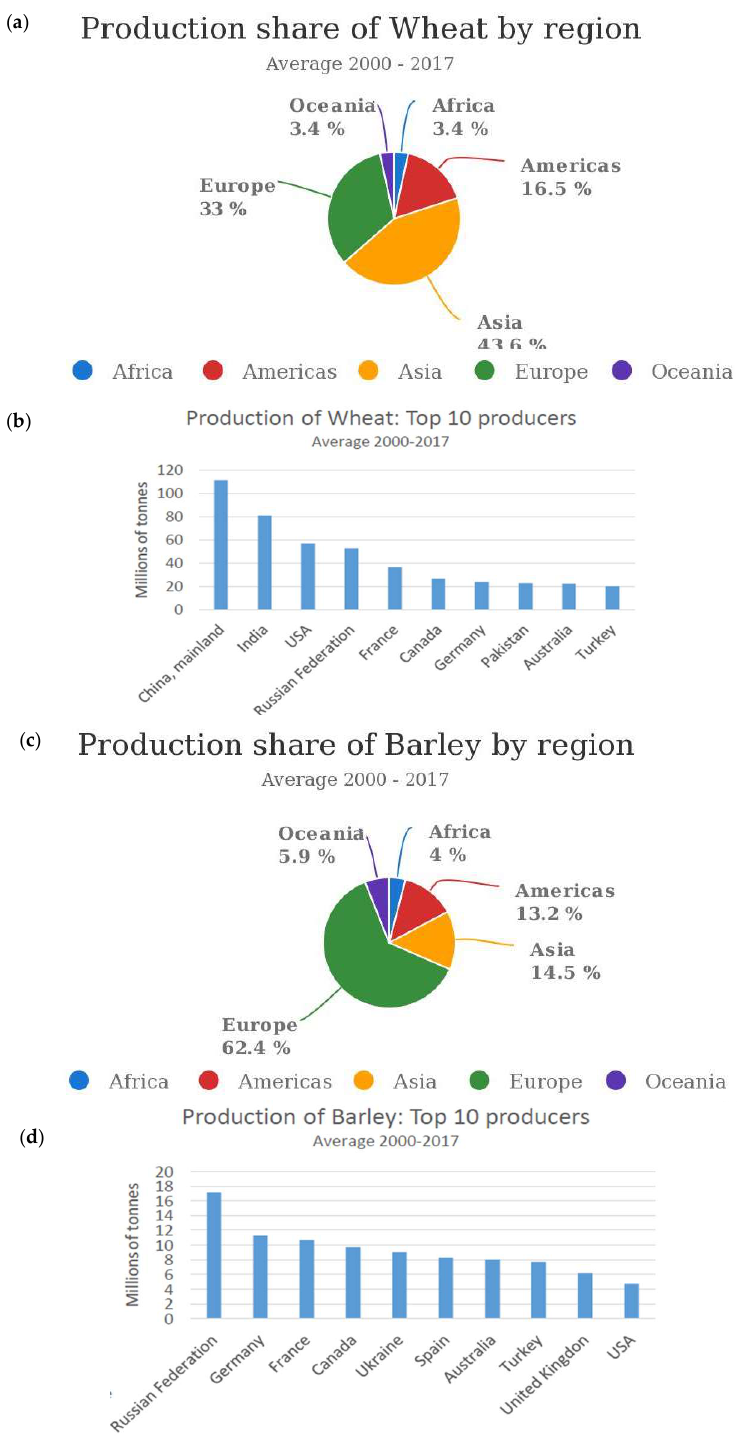
Figure 3. Wheat ( a , b ) and barley ( c , d ) production by regions ( a , c ) and by countries ( b , d ). Source: FAOSTAT.